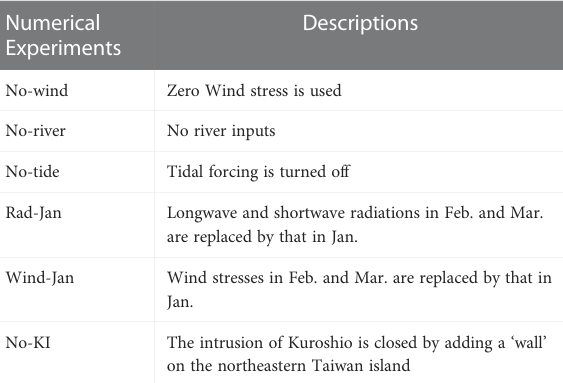
TABLE 4 Key con fi gurations of sensitive